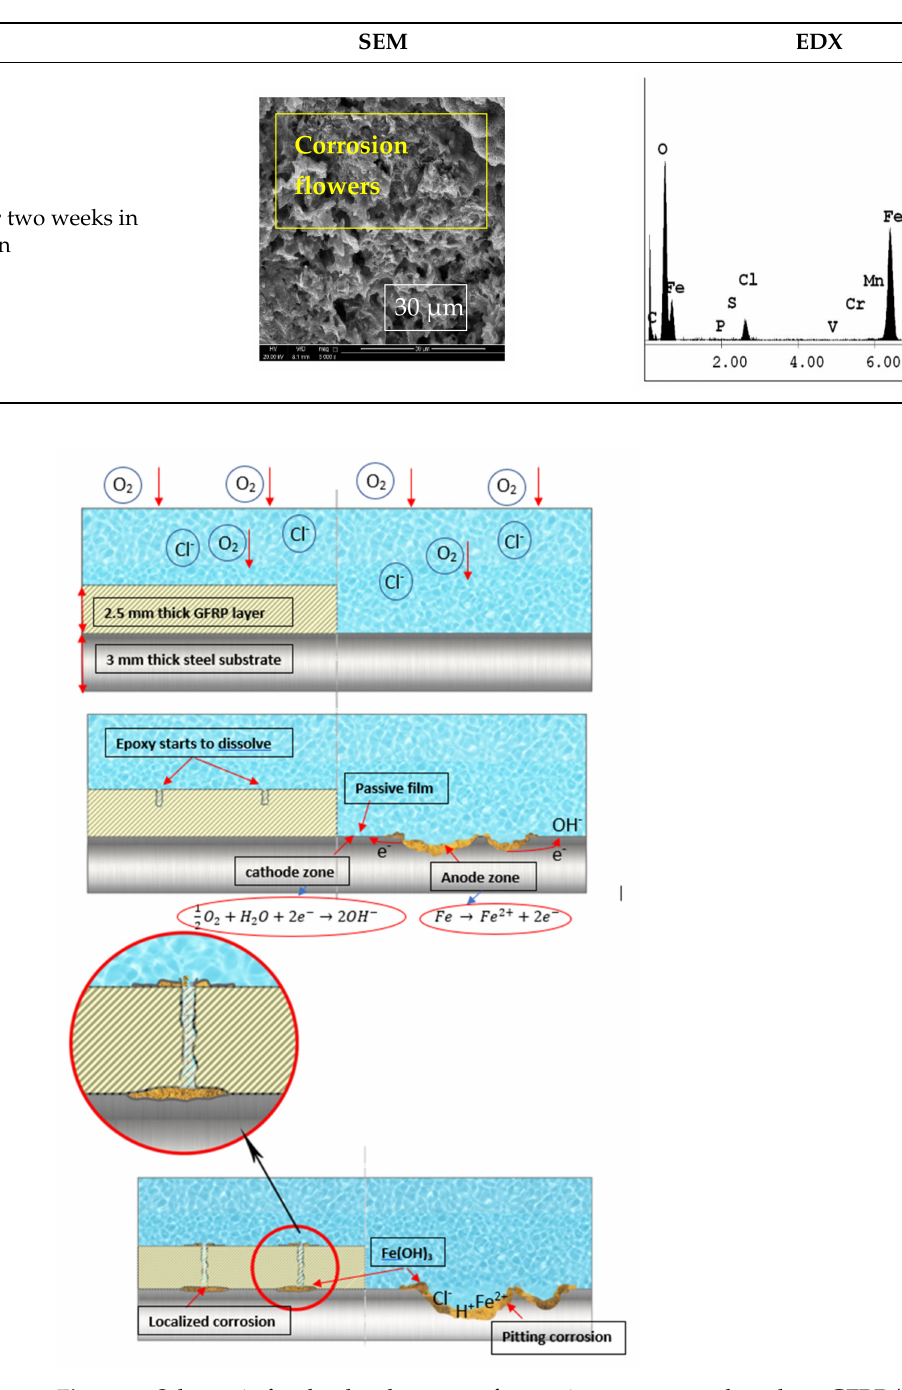
Figure 4. Schematic for the development of corrosion on uncoated steel vs. GFRP/steel in corro- sive